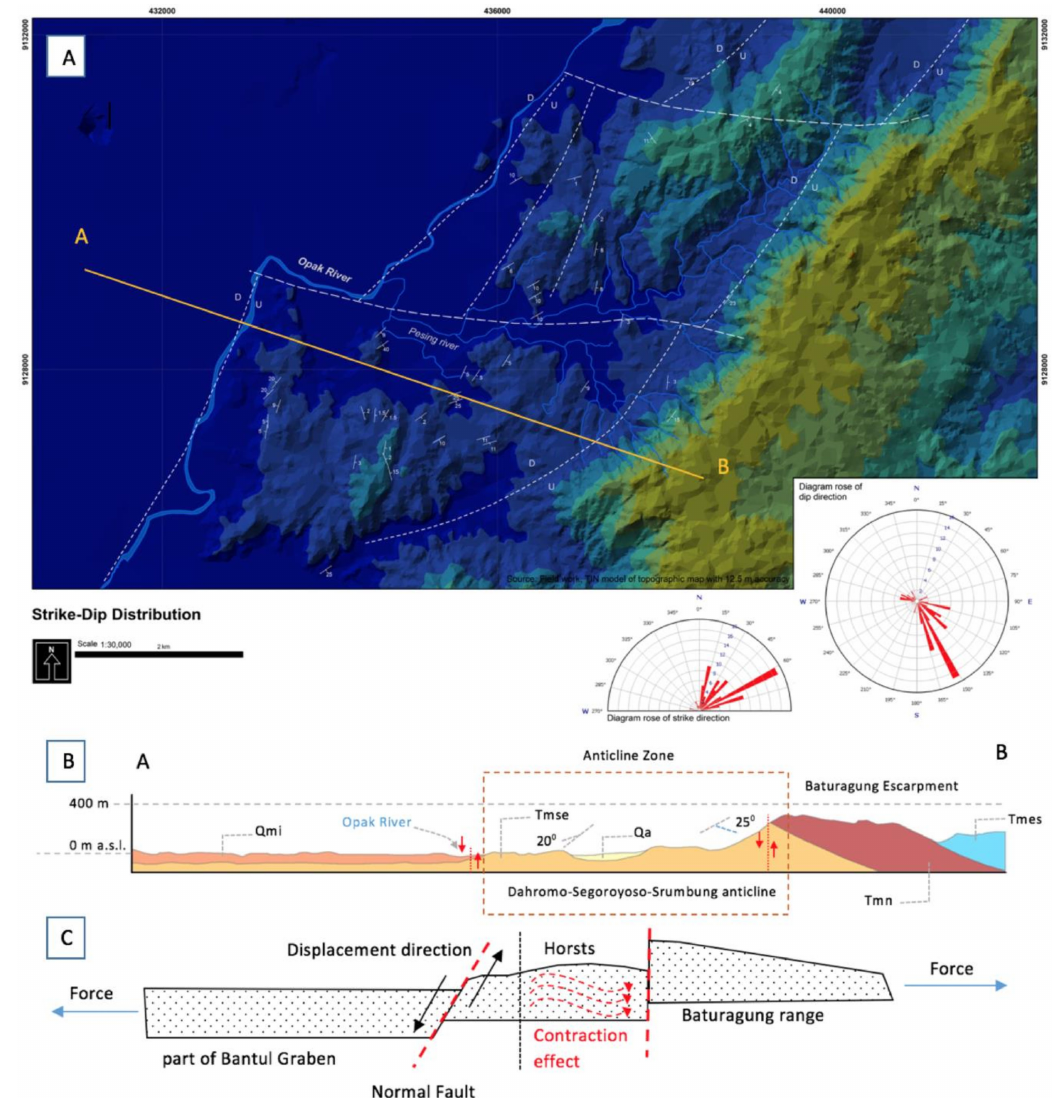
Figure 15. ( A ) Strike and dip map; ( B ) Cross sectional view of profile A–B; ( C ) Illustration of contraction effect and anticlinal formation in the folded hill between Opak Fault and Baturagung